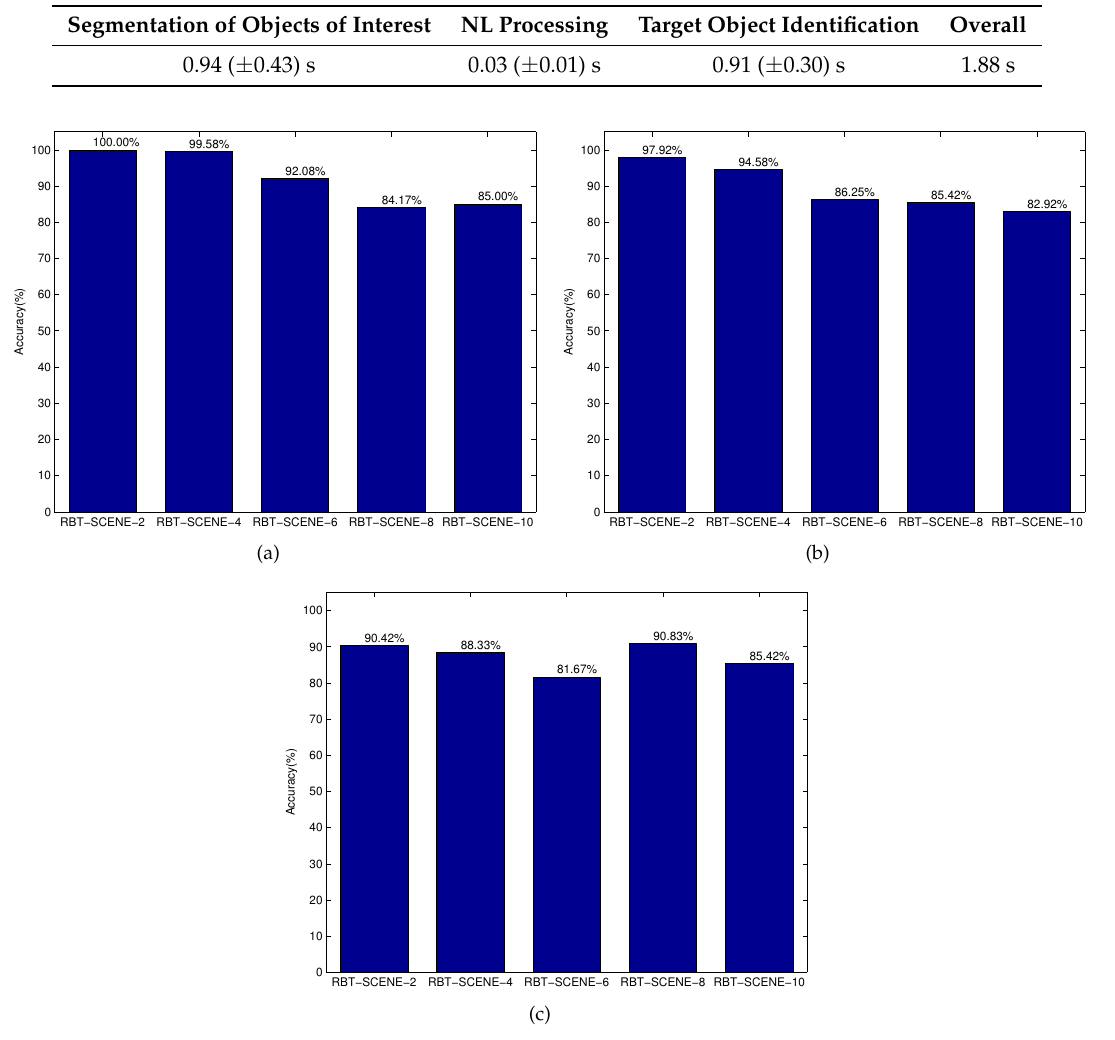
Figure 9. The accuracies of target object detection over different subsets of the RBT-SCENE dataset using three groups of NL instructions, NL-INST-1 ( a ), NL-INST-2 ( b ) and NL-INST-3 ( c